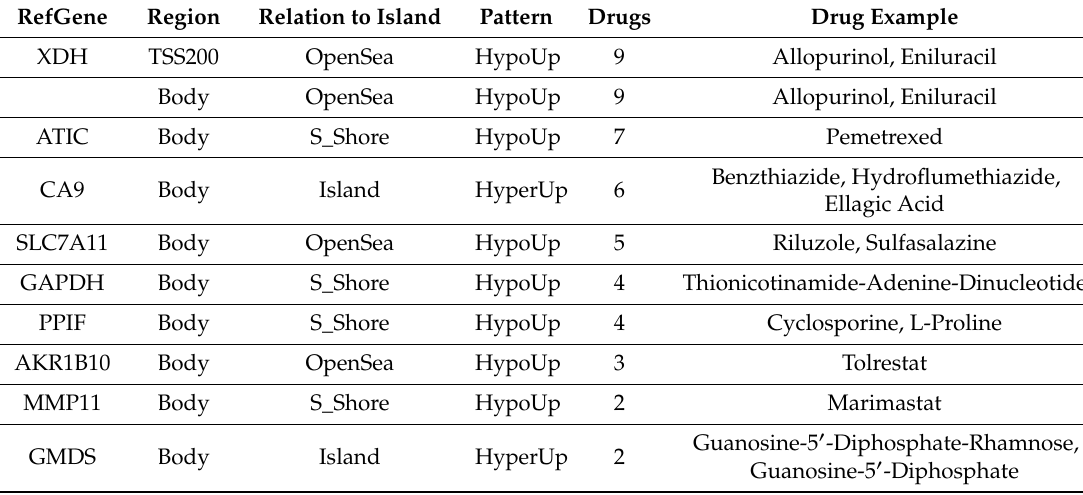
Table 3. Nine DMEGs targeted by available